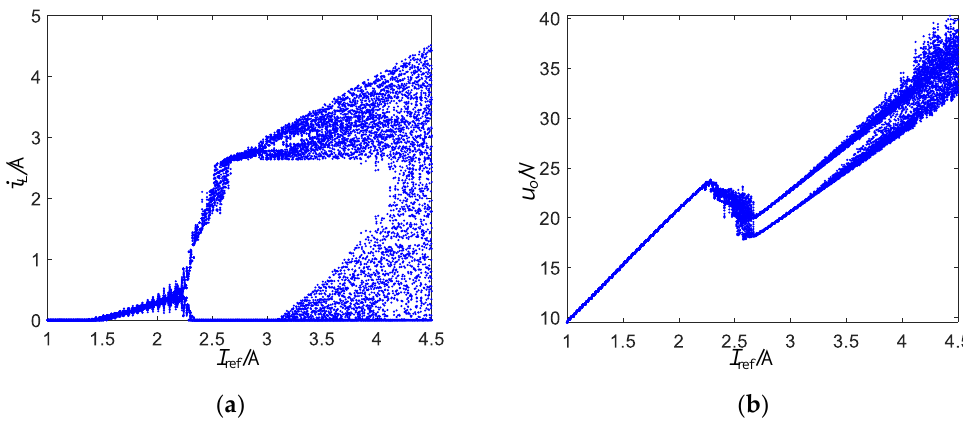
Figure 4. A bifurcation diagram of the FO buck – boost converter with I ref as a parameter: ( a ) the inductive current i L ; ( b ) the output voltage u o .